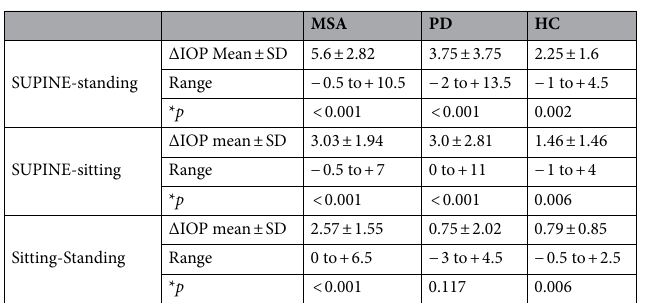
Table 3. Difference in IOP (in mmHg) between different positions among the three groups. * p = Wilcoxon test.